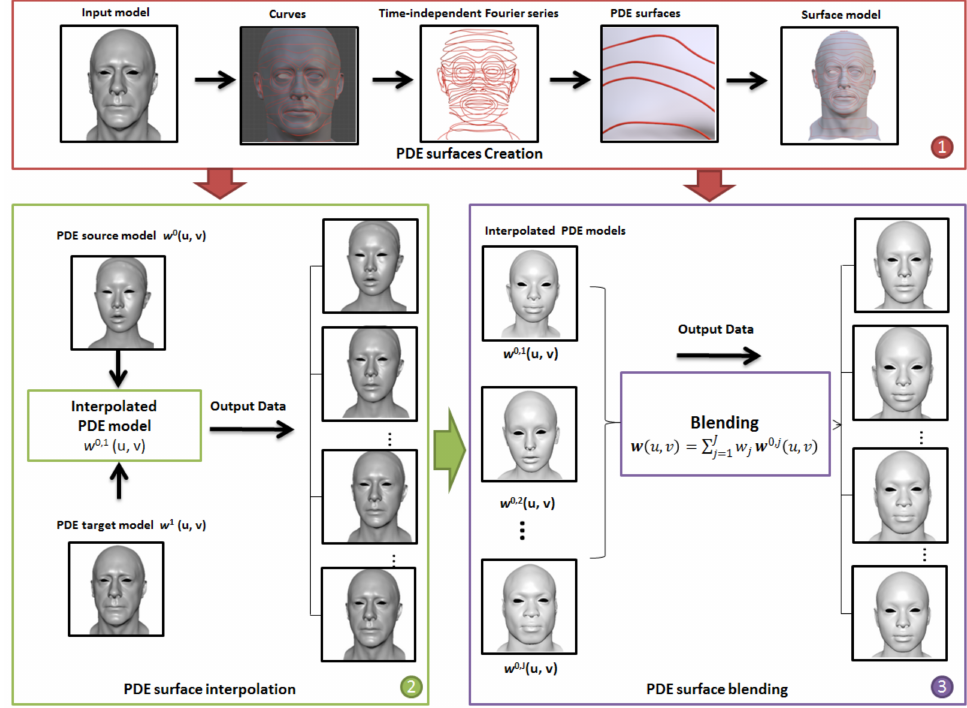
Figure 2. Algorithm